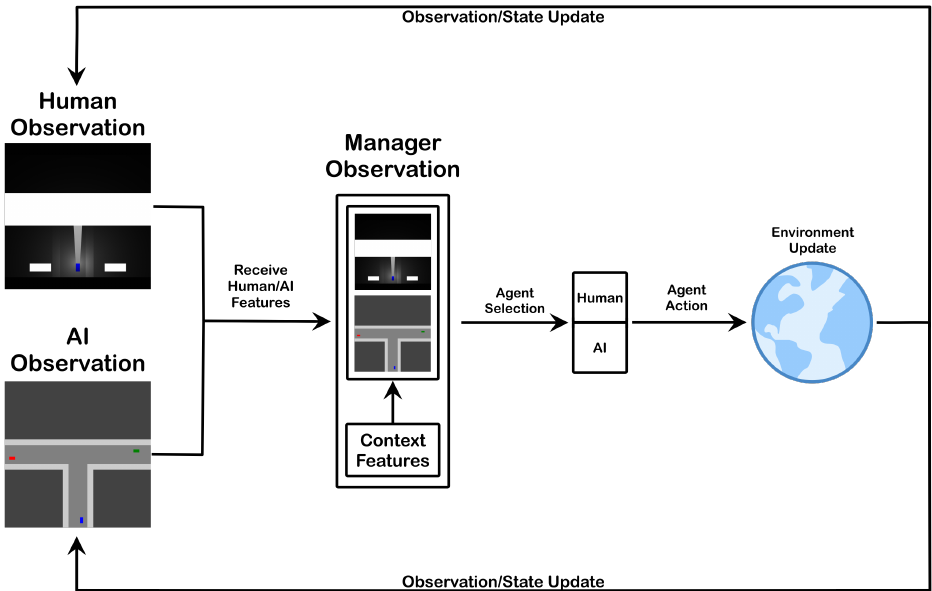
Figure 1. Diagram of manager and agent observation, selection, action, and environment